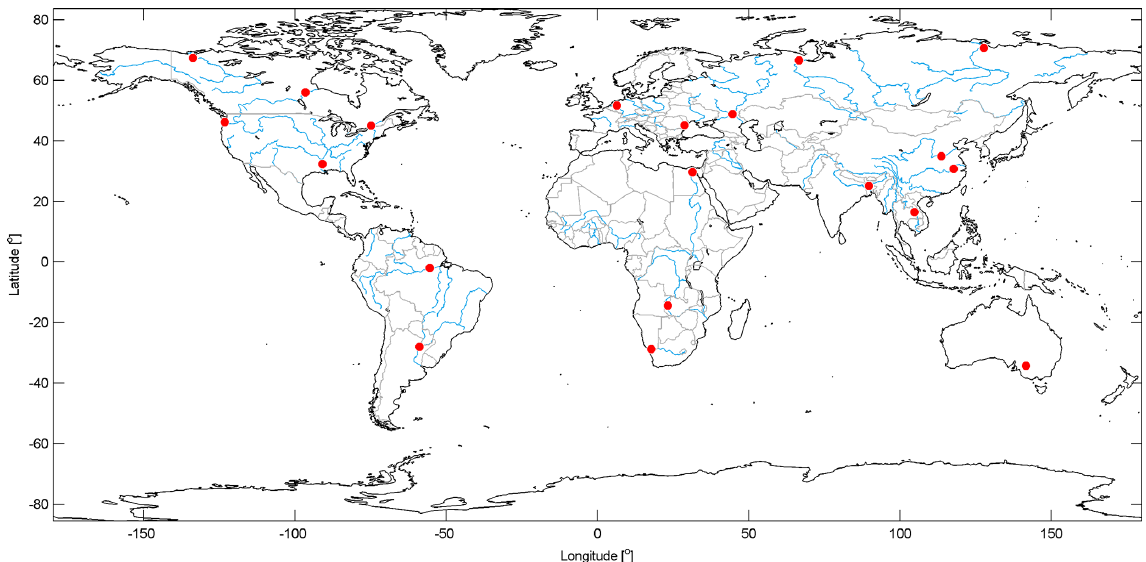
Figure 1. Selected